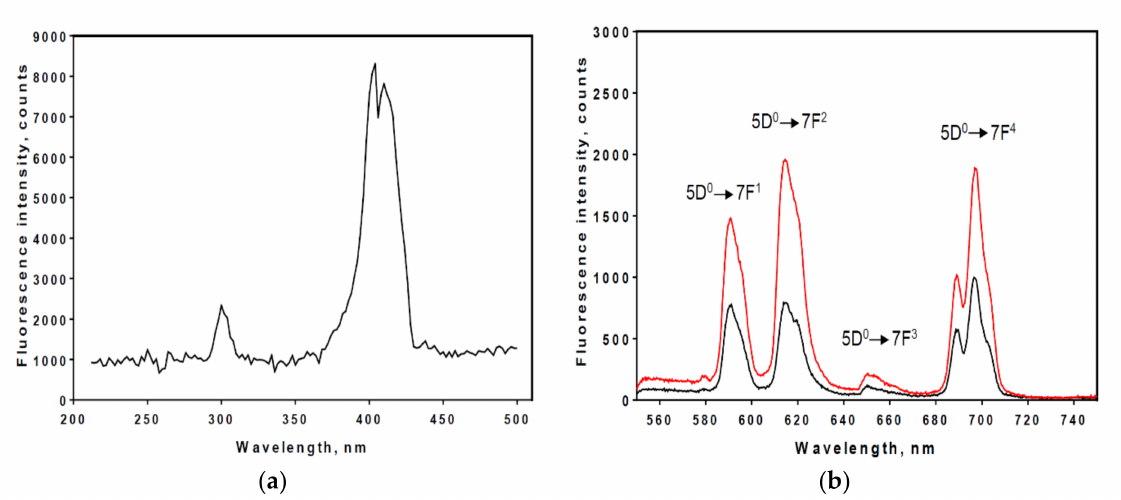
Figure 3. Excitation and emission spectra of Eu 3+ complex. ( a ), peak excitation wavelengths for Eu 3+ complex were measured and using λ em = 615 nm; ( b ), peak emission wavelengths for Eu 3+ complexes were measured for free Eu 3+ (black line peaks) and Eu 3+ chelated by PMDA modified anti-human myoglobin Affimer complex (red line peaks). The electronic transition corresponding to the emission peaks are indicated. λ ex = 395